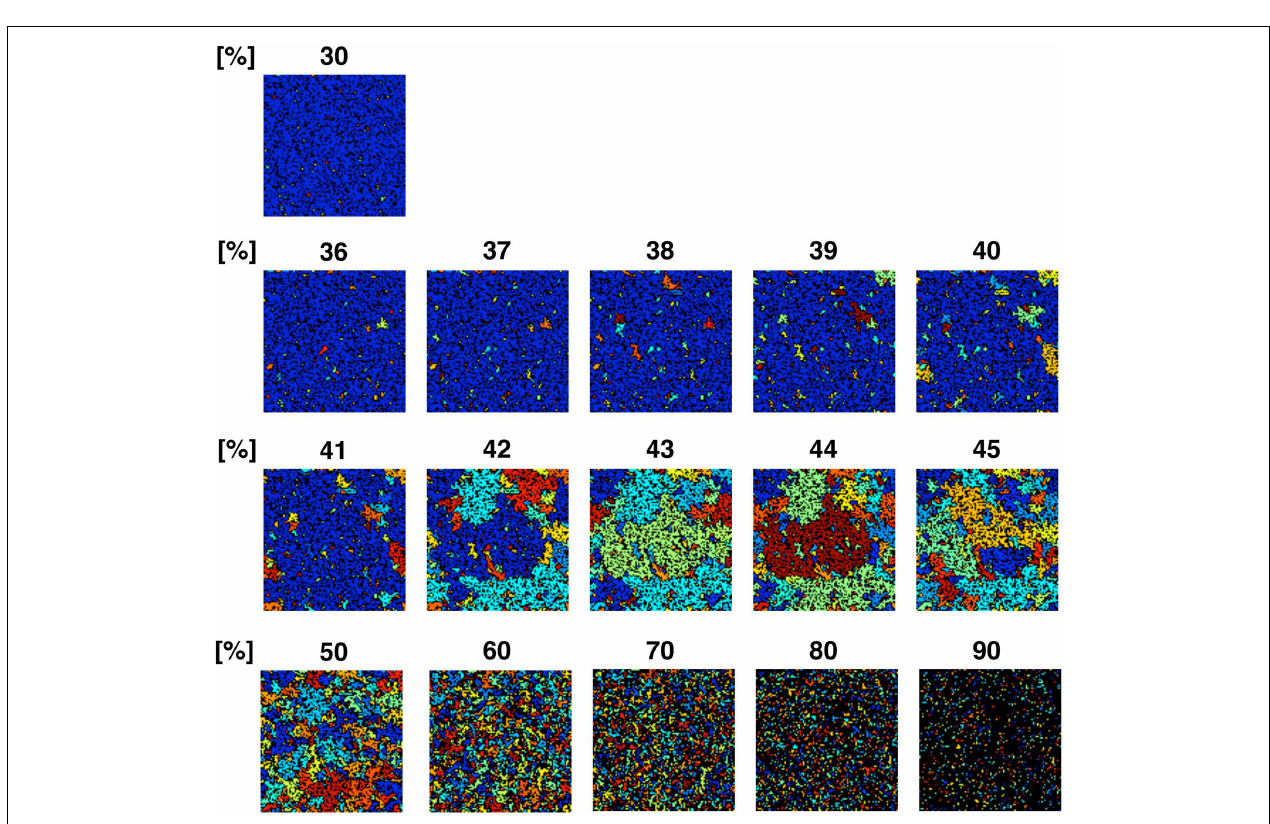
partitions appeared among the spaces with 42–45% NRO.With more or less occupied by NRO, the major part of partitions consists of small and huge size